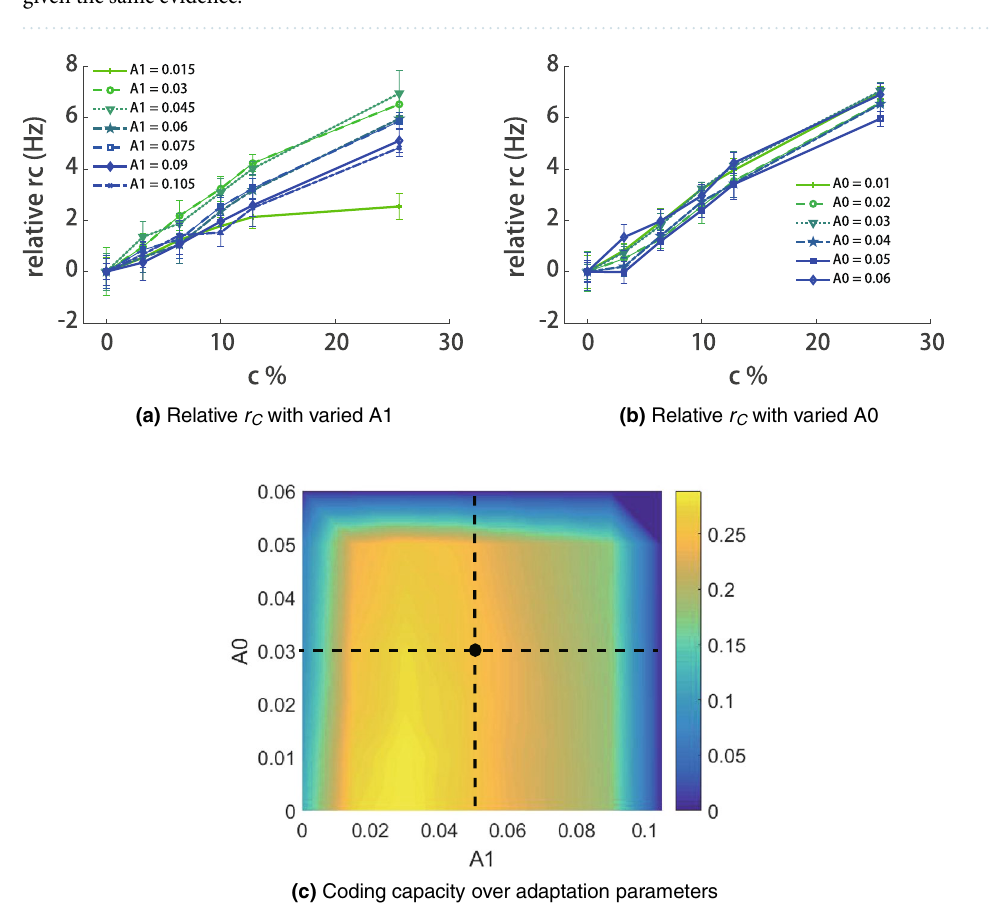
Figure 5. The influence of adaptation parameters on confidence representation. ( a ) The effects of A 1; ( b ) The effects of A 0; ( c ) The dependence of coding capacity on adaptation parameters.The error bars in ( a ) and ( b ) show the standard error of 10 sessions. Different colors in ( c ) code the average slope of